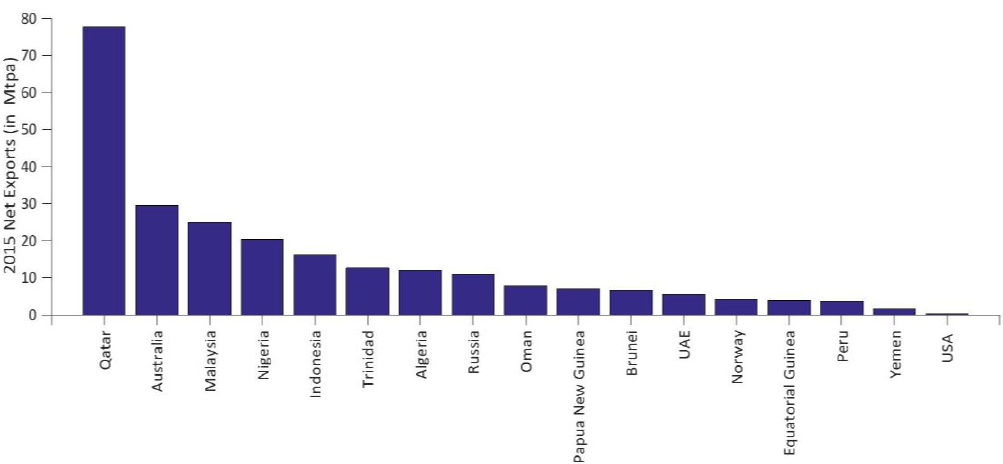
Figure 2. Global LNG exporting countries and quantity 2015.